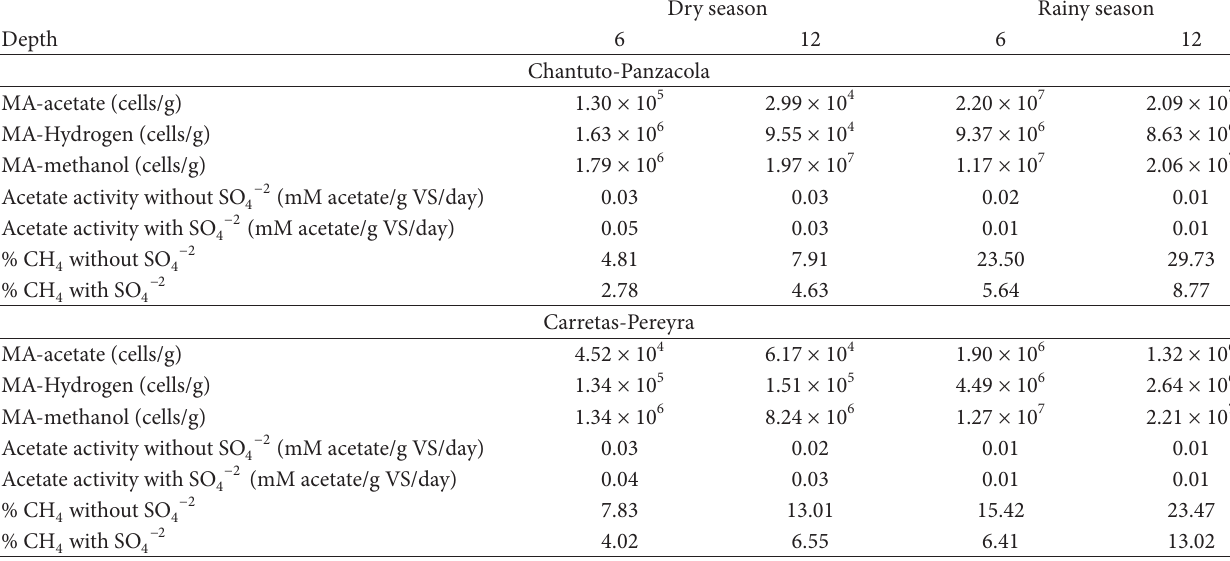
T 3: Abundance of MA, acetoclastic activity, and methane production in sediments of Chantuto-Panzacola and Carretas-Pereyra, Chiapas. Mean